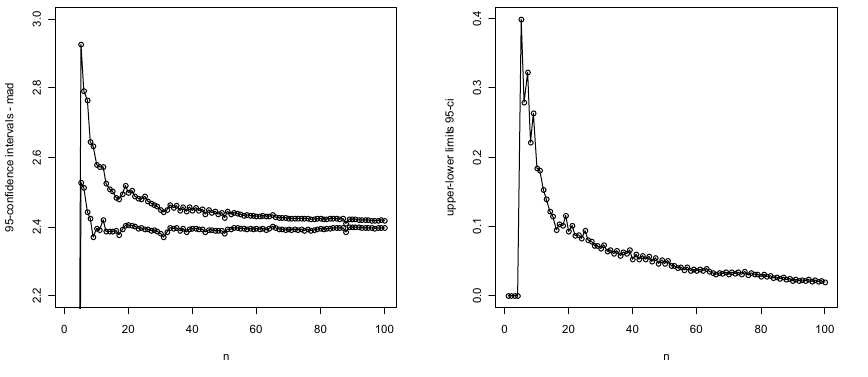
Figure 12 – Bootstrap estimation of MAD with samples of n between 5 and 100 units: boot- strap estimated 95% confidence intervals.